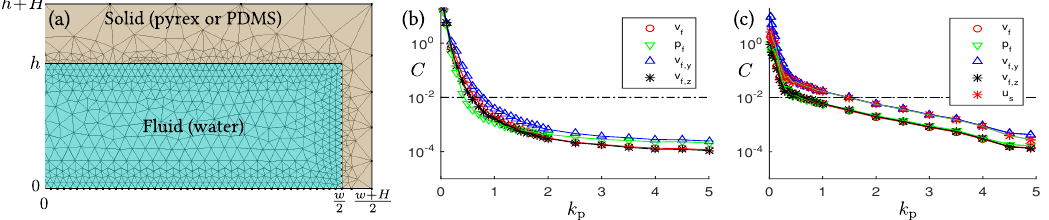
Figure 6. ( a ) The mesh implemented in COMSOL 5.2 (COMSOL, Stockholm, Sweden), here shown in a coarse version for illustrative purposes with the small value k p = 0.1 for the mesh parameter; ( b ) For each of the fields p f , v f , v f, y , and v f, z , the relative mesh convergence parameter C is plotted versus mesh parameter k p for the reduced lossy-wall model. The dashed line represents C = 0.01; ( c ) The same as in ( b ) but for the water domain in the full PDMS model with the inclusion of the field u s